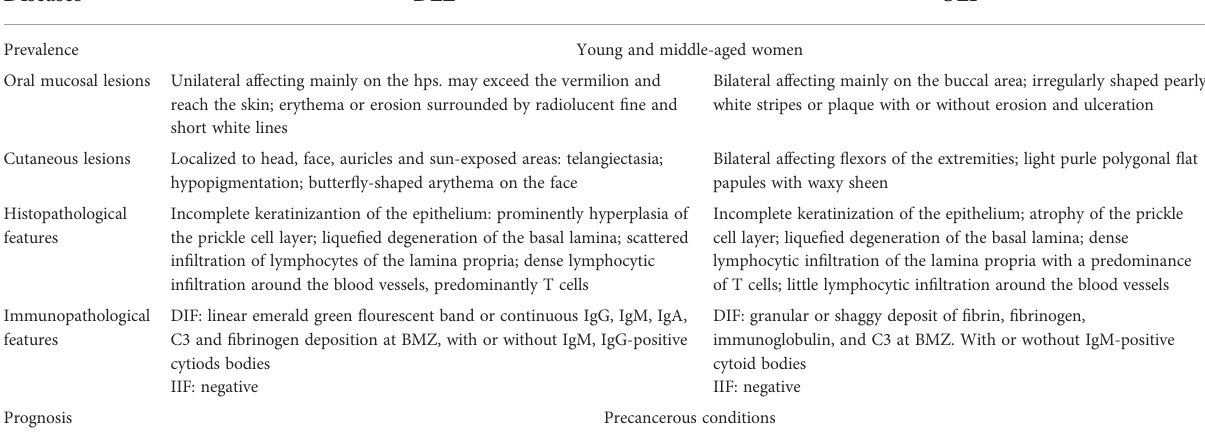
TABLE 1 Classi fi cation and characteristics of OLP and DLE. Diseases DLE OLP Prevalence Young and middle-aged women